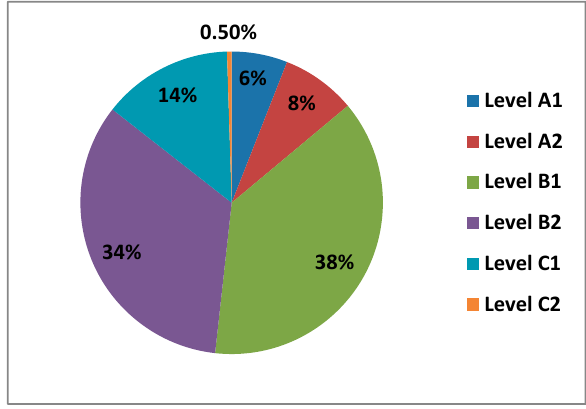
Figure 7. Teachers by level of self-perceived digital competence.